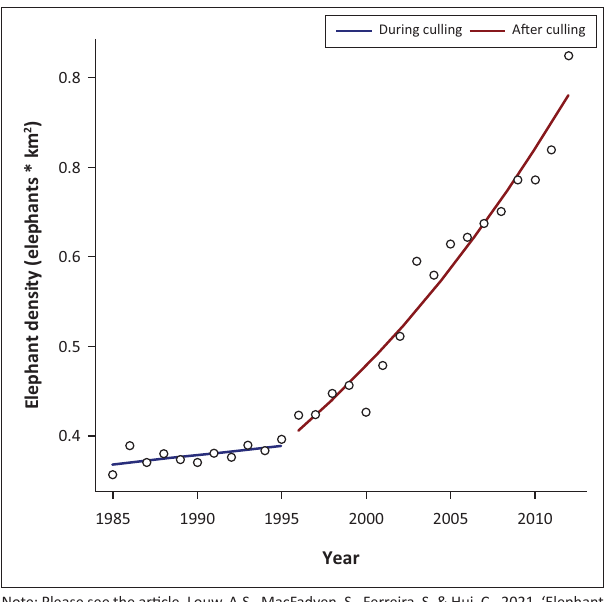
FIGURE 2: Time series of park-wide elephant density in elephants per square kilometre, as obtained from annual census (circles). Lines represent exponential growth models (Eqn 2) fitted to the census time series for the period with culling (1985–1995) in blue and without culling (1996–2012) in